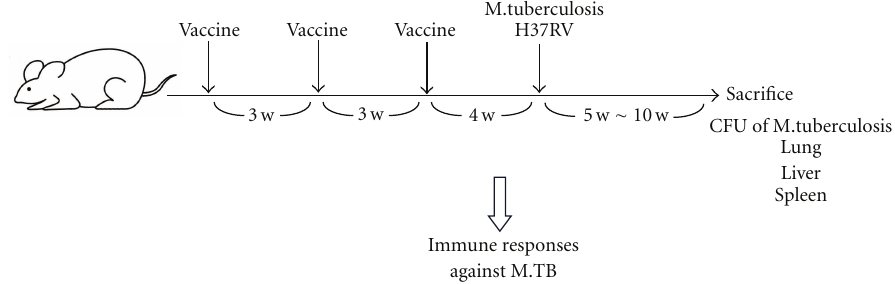
Figure 2: Groups of mice were vaccinated 3 times every 3 weeks using the prime-boost method and challenged intravenously with M. tuberculosis H37Rv as described in the Materials and Methods section. Five or 10 weeks after challenge with TB, protection was measured by enumerating bacterial loads (CFU) in the lungs, liver, and spleen of the vaccinated